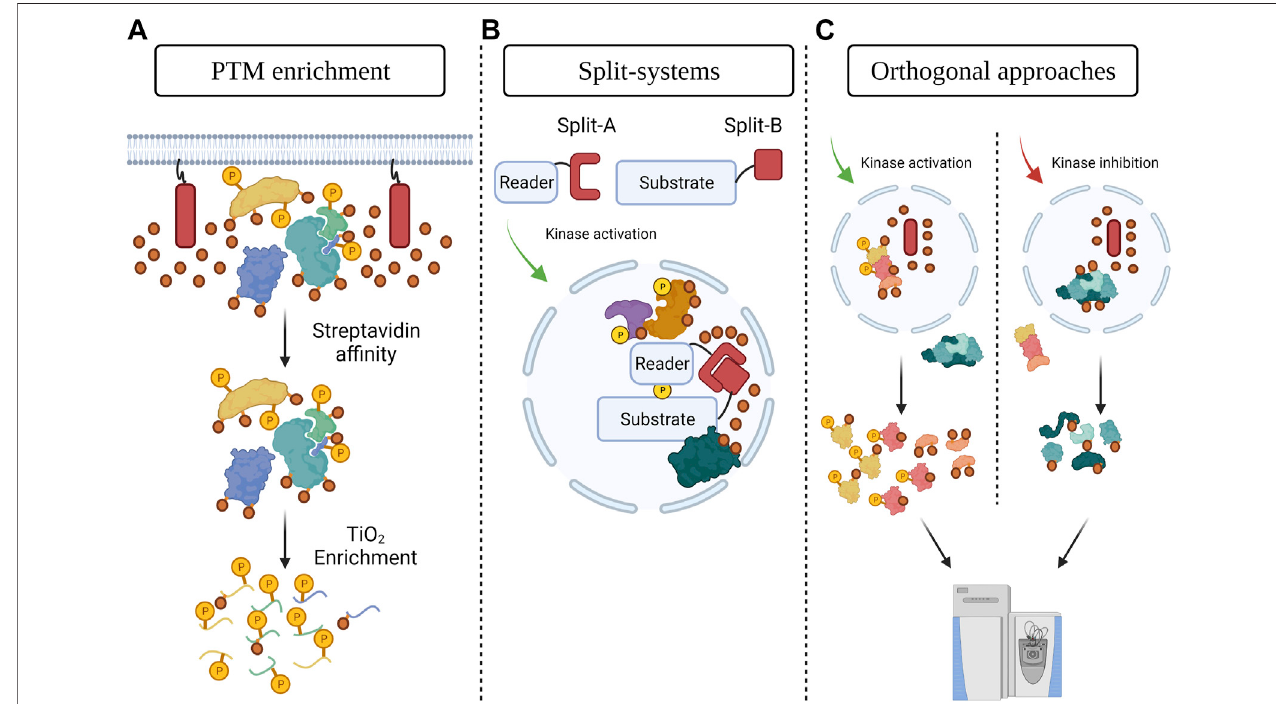
FIGURE1| PDBstrategiestostudythecontributionsofphosphorylationtoproteomecompartmentalization (A) CombiningPDBwithphosphopeptideenrichment. A biotinylating enzyme (red rectangle, biotin is represented by orange circles) is targeted to a speci fi c cellular structure to label its spatial subproteome. Streptavidin af fi nity puri fi cation is followed by TiO 2 enrichment to identify local phosphosites. This concept could be applied to other PTM enrichment strategies as well. (B) Protein engineering strategies, such as split-PDB systems, can be used to investigate the consequences of spatially resolved PTMs such as phosphorylation. A reader domain foraspeci fi ctypeofphosphorylationisfusedtoonehalfofthePDBenzymeand thesubstrateofinterest(localizedtoaspeci fi csubcompartment)isfusedtothe otherhalf.TheimpactsofphosphorylationoftheproteinofinterestcanthenbedeterminedviaPDB-MS. (C) CombiningPDBtools(redrectangleandorangecircles)with orthogonal approaches (curved arrows). PDB is achieved in a speci fi c cellular structure and PTM-generating enzymes are modulated via orthogonal strategies (e.g., optogenetically or chemically). Impacts on the spatial proteome are determined using streptavidin af fi nity puri fi cation and MS. Figure generated with